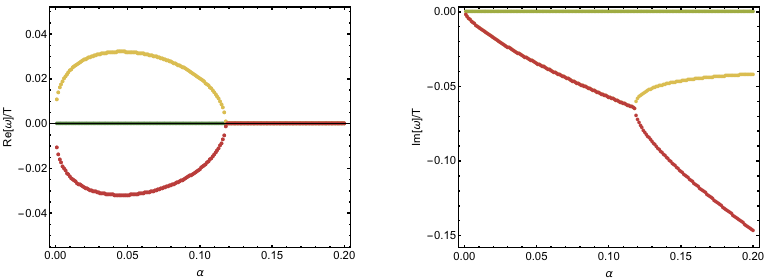
Figure 23 . Lowest modes in the longitudinal sector of the (cid:13)uid model V ( Z ) = (cid:11)Z + (cid:12)Z 2 . The parameter are (cid:12)xed to m=T = 0 : 1 ; (cid:12) = 5 and the EXB scale (cid:24) (cid:11)